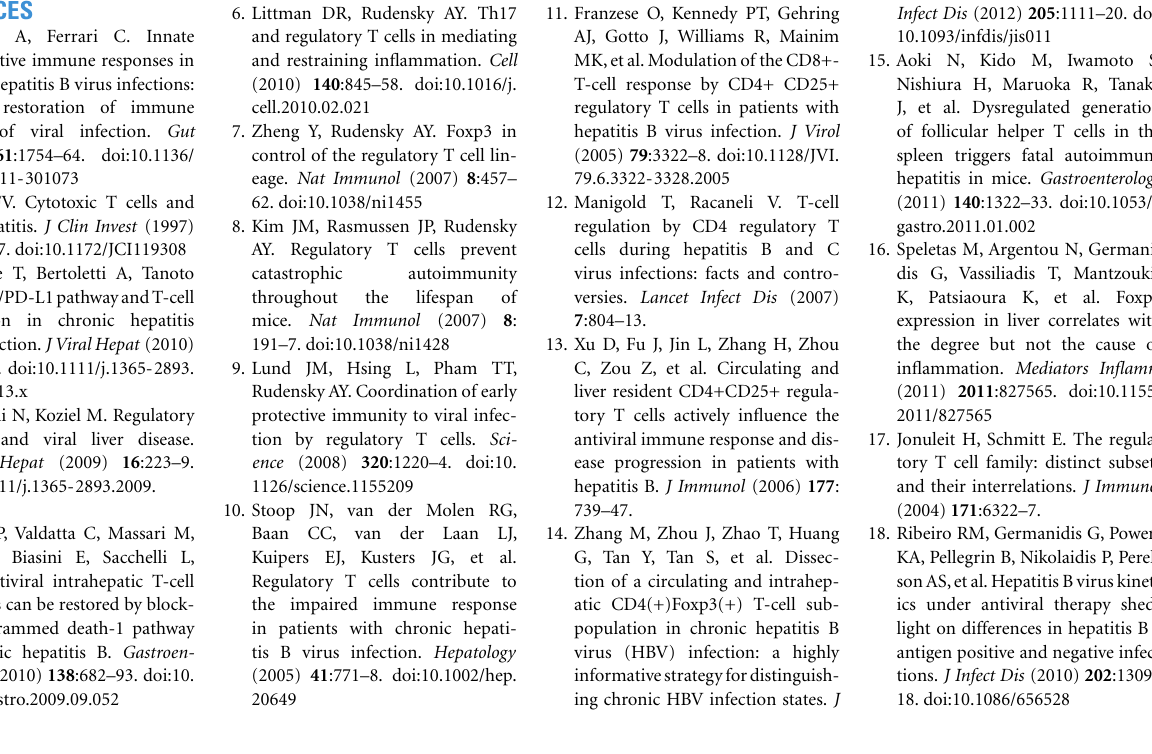
FIGURE 4 | Gene expressions in the liver of all CHB patients, according to the intensity of liver inflammation and fibrosis . Boxplot diagrams presenting the expression of FOXP3 (A) , PD1/PDCD1 (B) , PDL1/PDCD1LG1 (C) , CD8a (D) , TNSF10/TRAIL (E) according to the intensity of liver inflammation (excluding a sole patient with HAI score 0), and the expression of PDL1/PDCD1LG1 (F) according to the severity of